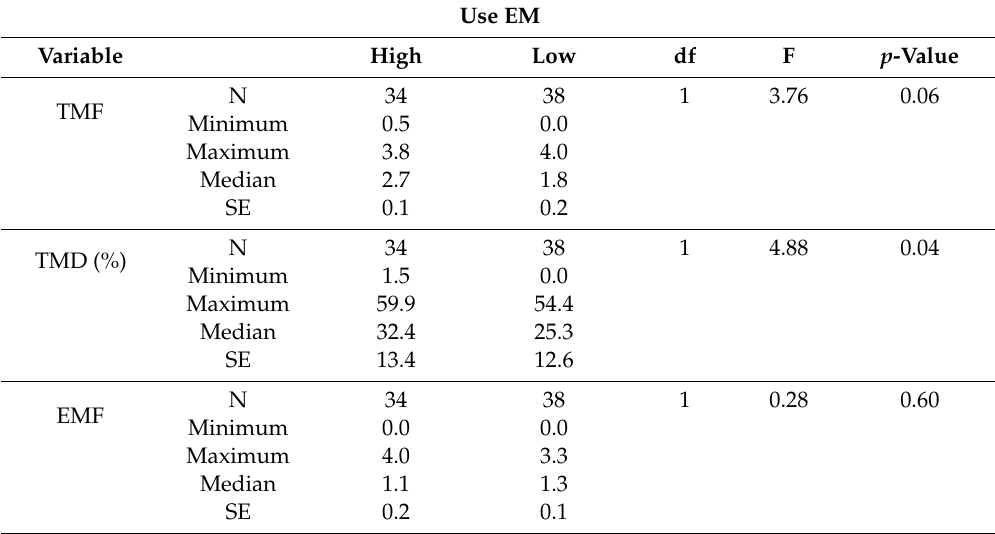
Table 2. Comparison of the variables (tail movement frequency, tail movement duration and ear movement frequency) over 12 weeks in relation to the use of enrichment (scored as “high” or “low”). Use EM Variable High